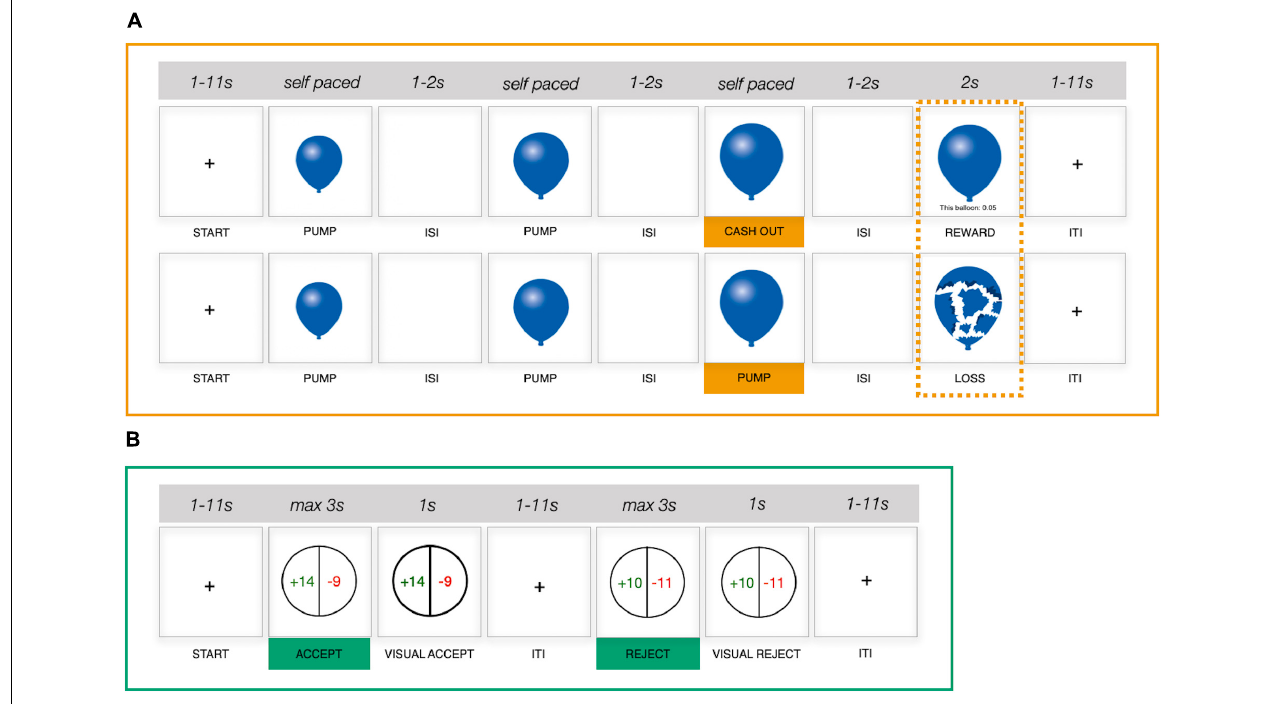
FIGURE 1 | Schematic representation of two functional magnetic resonance imaging (fMRI) risk-taking measures. (A) Balloon Analog Risk Task (BART), upper row , example cash-out trial; lower row , example explosion trial. (B) Monetary gambles. ISI, interstimulus interval; ITI, intertrial interval; s,